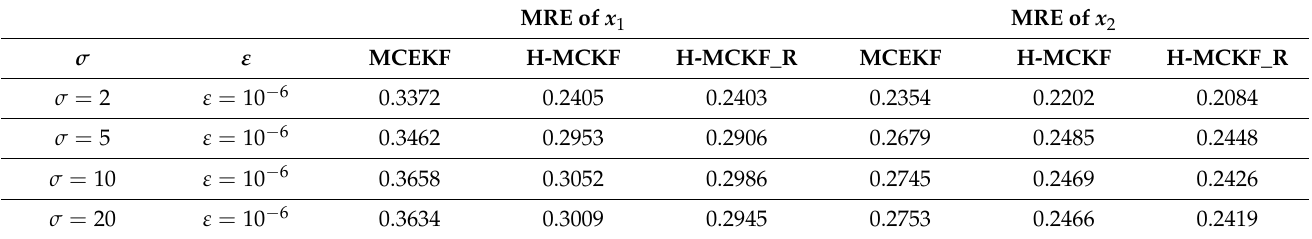
Figure 3. ( a , b ) Set parameters: